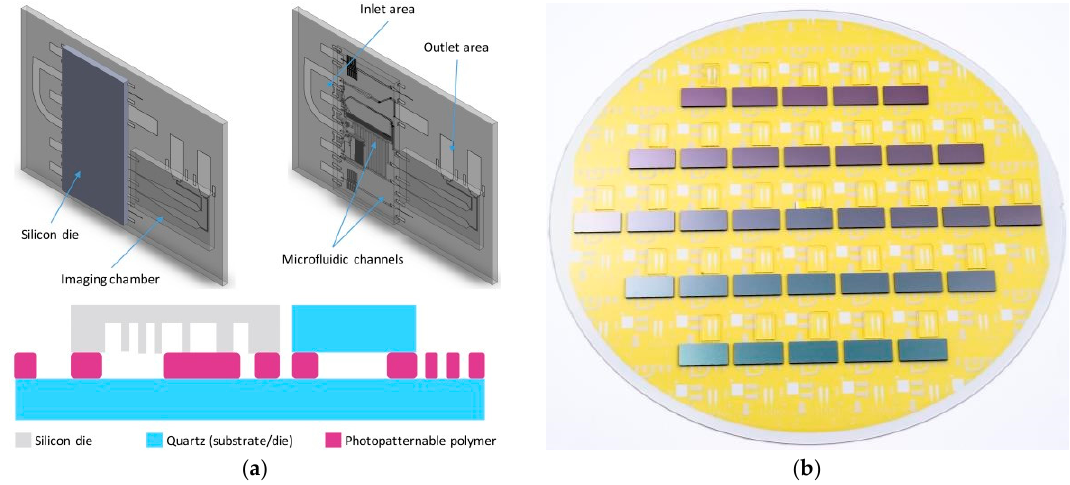
Figure 1. ( a ) Device schematics. ( Top ) 3D view of the main system components. ( Bottom ) Microchip cross-section view; ( b ) Image of the 200 mm wafer populated with silicon and quartz